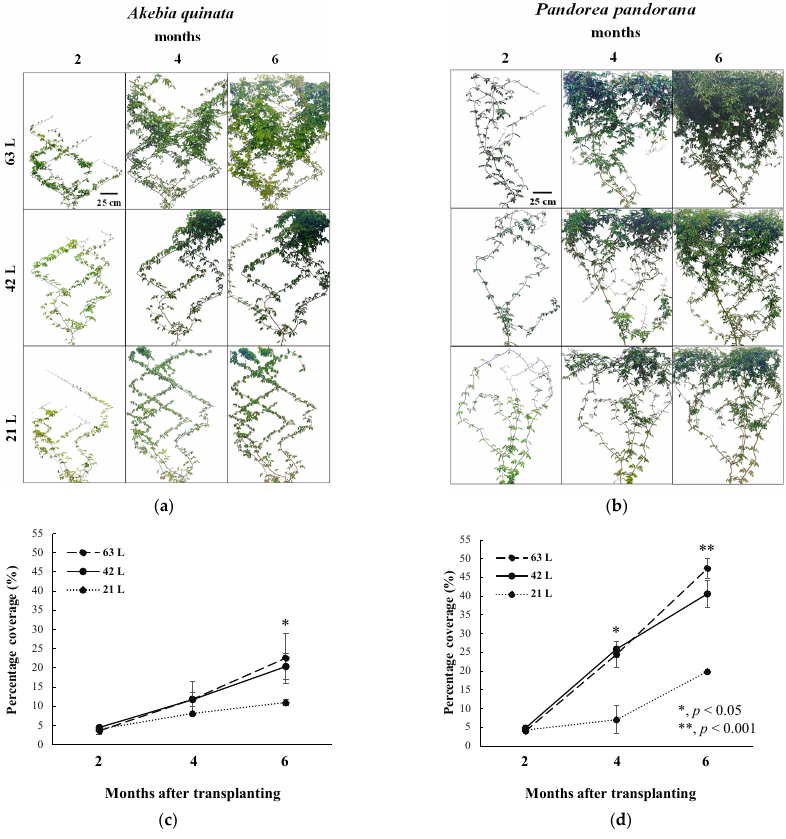
Figure 2. Percentage wall coverage of Akebia quinata ( a , c ) and Pandorea pandorana ( b , d ) grown in three different rooting volumes after two, four, and six months of growth after transplanting. Values are means ± SE. The biomass growth of both climbing plants was strongly affected by the rooting volume ( p < 0.001) (Figure 3a). The total biomass of A. quinata and P. pandorana more than doubled (+107% and +141%, respectively) when grown in 42 L or 63 L compared with 21 L. However, there was no significant difference in the biomass of either climbing plant species for the plants grown in 42 L and 63 L rooting volumes. After six months of growth, P. pandorana had more than double the biomass of A. quinata under the same rooting vol ‐ ume treatments. Shoot/root biomass allocation was unaffected by rooting volume, with no significant differences for either climbing plant species (Figure 3b). However, between the two spe ‐ cies, P. pandorana allocated more biomass to shoots than A. quinata for all of the rooting volume treatments. ( a ) ( b ) Figure 3. Average total biomass ( a ) and average shoot/root ratio ( b ) of Akebia quinata and Pandorea pandorana plants grown in three different rooting volumes after six months of growth. Values are means ± SE. Different letters represent significant differences within species, p < 0.001; lowercase, Akebia quinata ; capital, Pandorea pandorana . The total leaf areas of A. quinata ( p < 0.01) and P. pandorana ( p < 0.001) were also sig ‐ nificantly affected by the rooting volume (Figure 4a). Both climbing plant species at least doubled their leaf area when grown in 42 L compared to 21 L. However, there was no significant increase in leaf area of either climbing plant species between plants grown in 42 L and 63 L rooting volumes. P. pandorana had a two ‐ or three ‐ fold greater leaf area than A. quinata , regardless of rooting volume. Similarly, SLA increased significantly with in ‐ creasing the rooting volume for both species ( p < 0.001) (Figure 4b). SLA increased from